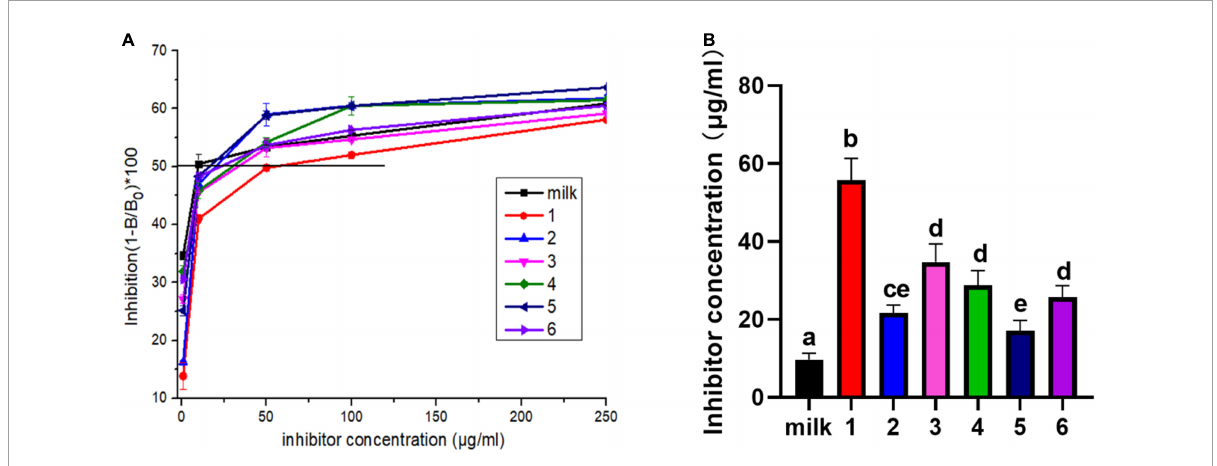
FIGURE5 IgE binding ability of yogurts was defined by competitive ELISA (A) . The inhibitor concentration corresponds to IC50 values of yogurts (B) . Lane 1: GuMi yogurt; Lane 2: JSD yogurt; Lane 3: HR yogurt; Lane 4: HN yogurt; Lane 5: JA yogurt; Lane 6: HS yogurt (Different letters represent significant differences, p <